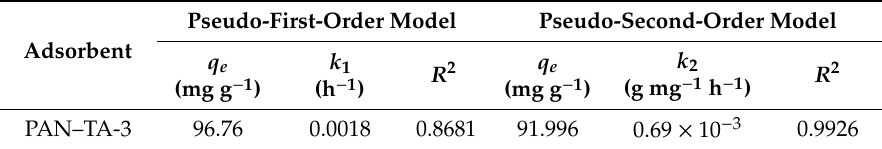
Table 1. Kinetic parameters for Cr(III) adsorption on